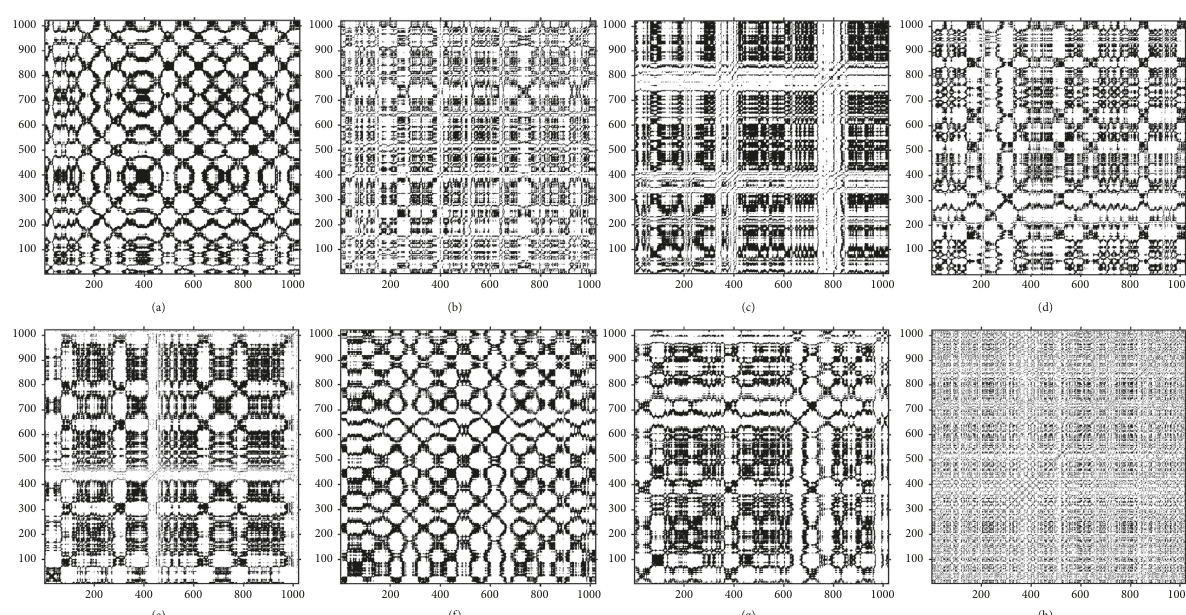
Figure 4: 8 RPs of 8 faulty motors. (a) NO. (b) BB. (c) BR. (d) RM. (e) SW. (f) VP. (g) RU. (h)